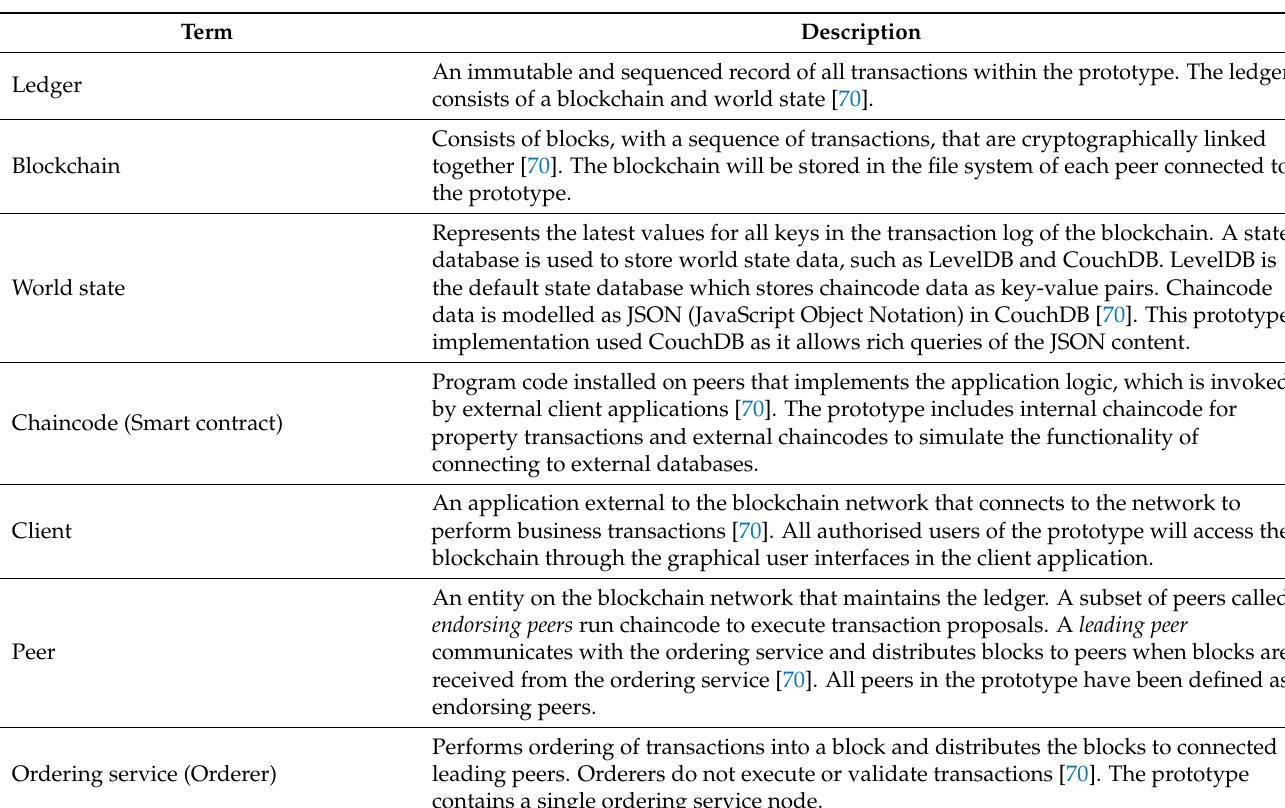
Table 3. The function of Hyperledger Fabric within the